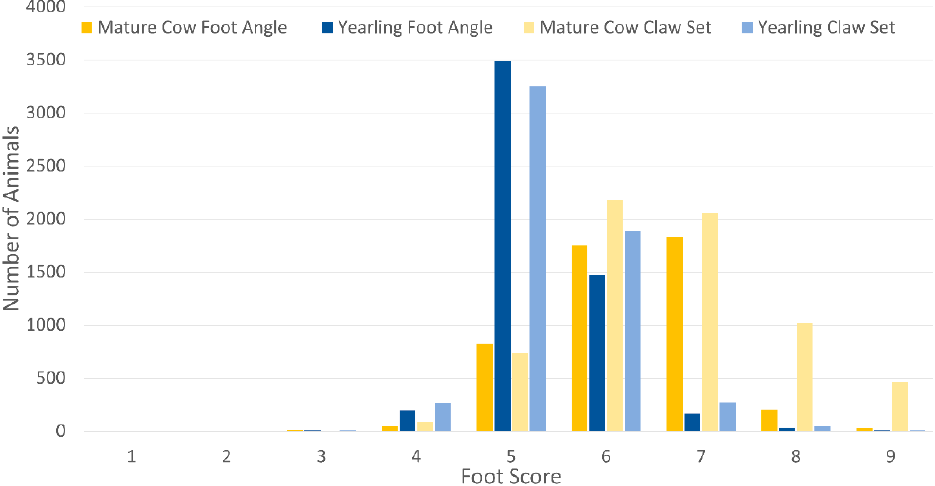
Figure 4. Angus Herd Improvement Records (AHIR) foot score data submissions of mature cows and yearlings using the American Angus Association Foot Scoring Guideline as of Spring 2020 [77].